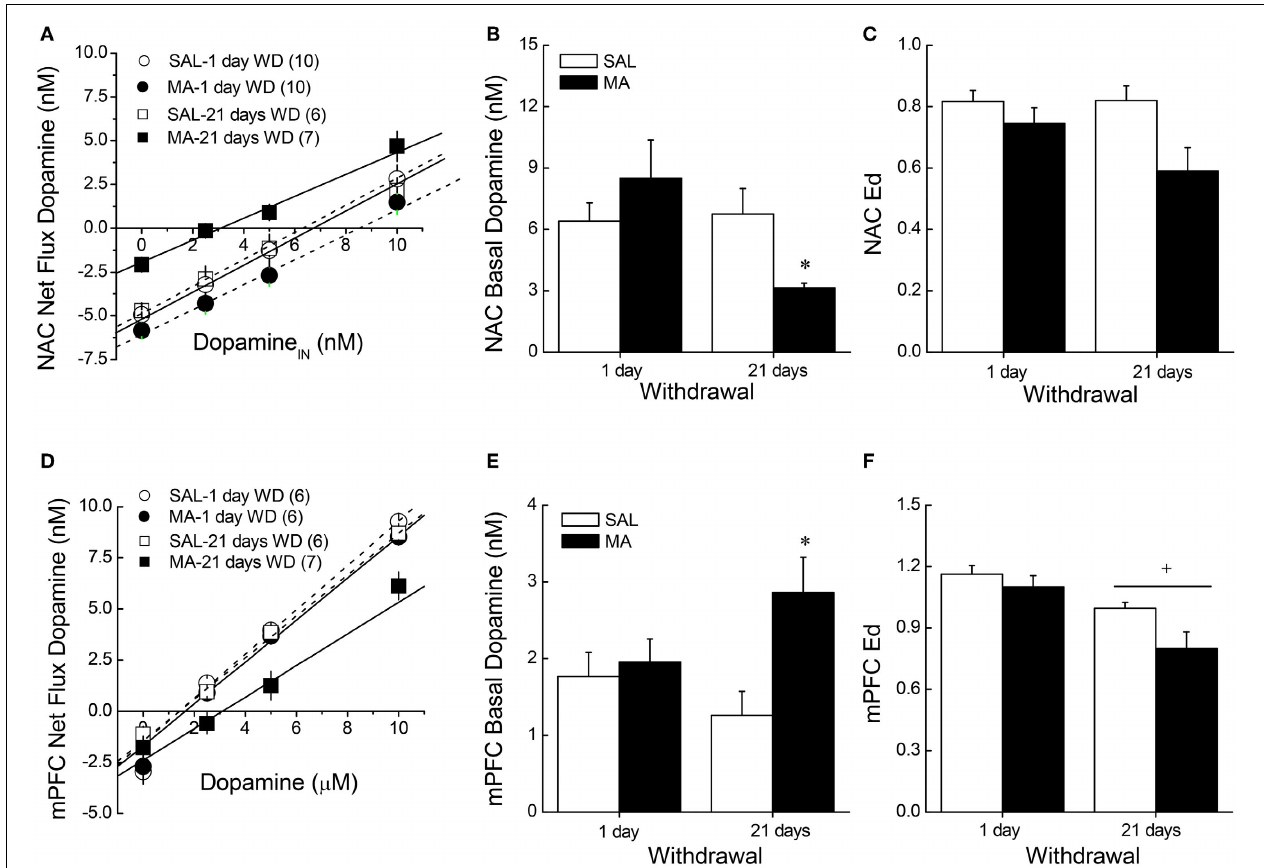
FIGURE 2 | Summary of the results of a dopamine no net-flux in vivo microdialysis study conducted at either 1 or 21 days withdrawal (WD) in B6 mice with a 10-day history of repeated methamphetamine (2mg/kg; MA) or saline (SAL) within the NAC core-shell interface (A–C) and the mPFC (D–F). Linear regression analyses (A,D) conducted on the plots of the net flux of dopamine vs. the amount of dopamine infused revealed